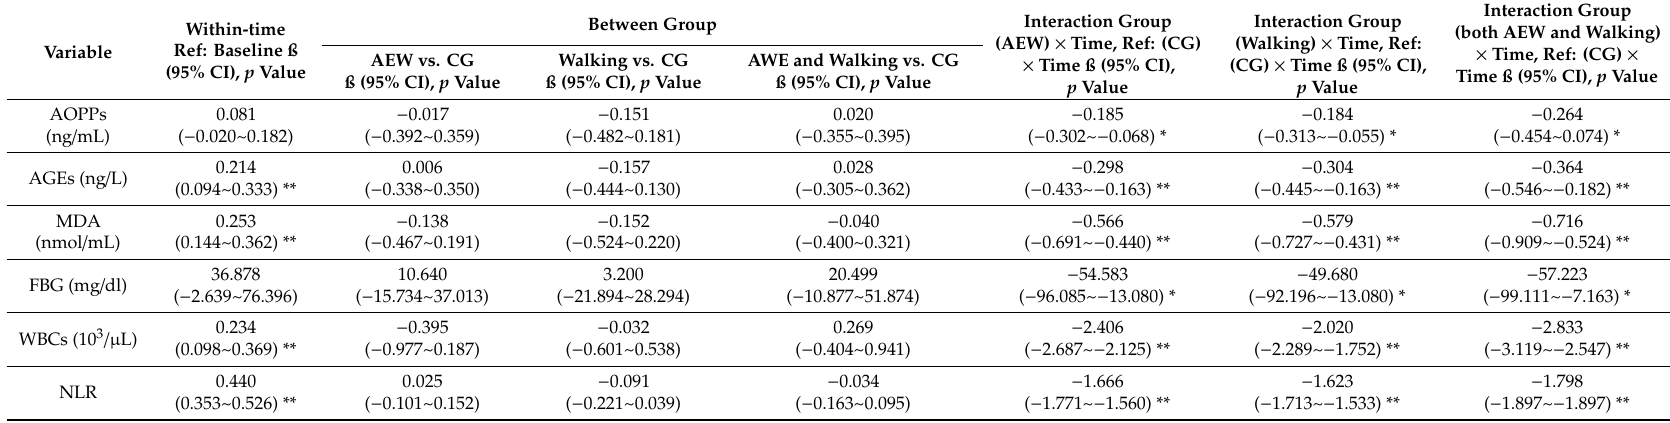
Table 5. Evaluation of the intervention on T2DM-associated inflammatory biomarkers based on a general estimating equation analysis ( n = 81).